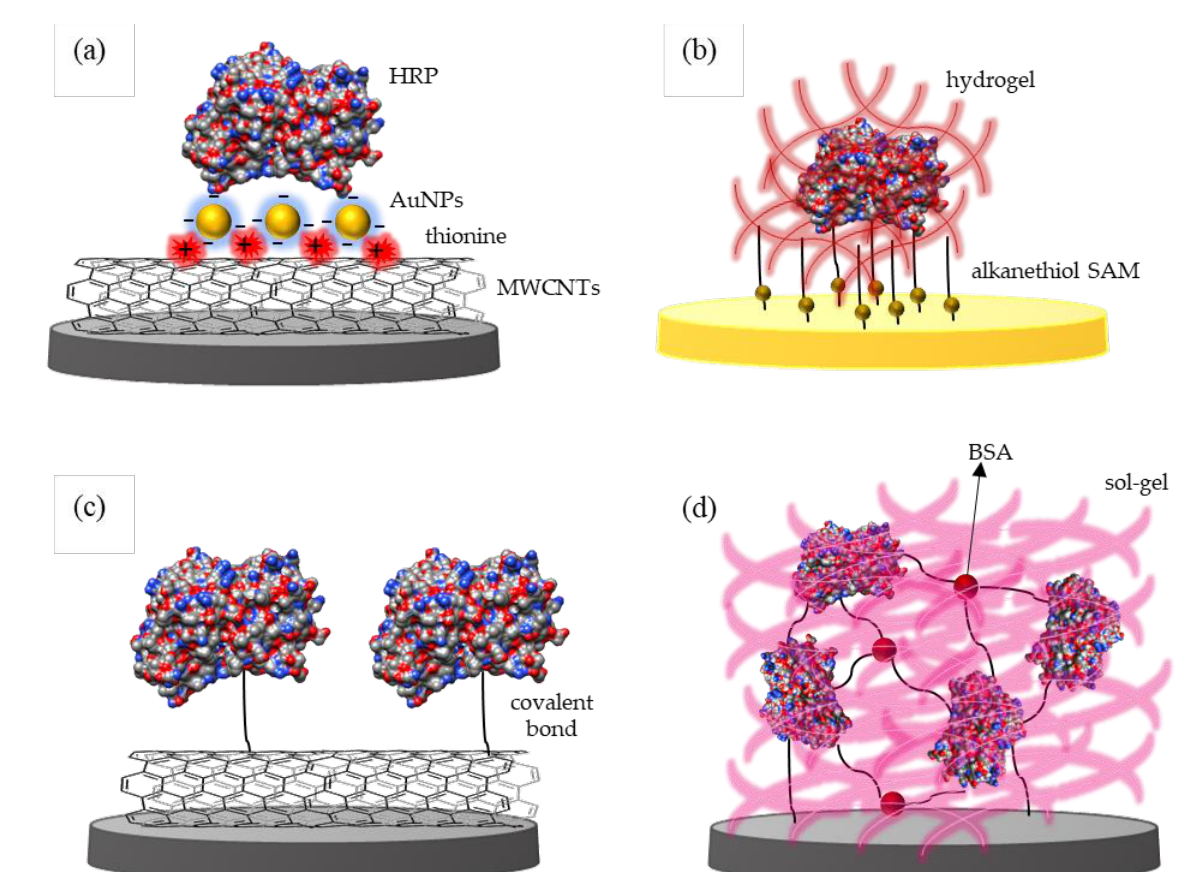
Figure 2. Enzyme immobilization methods. ( a ) A dsorption onto a multi-walled carbon nanotubes (MWCNTs)/thionine/Au nanoparticles (NPs) composite film on glassy carbon (GC) [37]; ( b ) entrapment of chemically modified enzyme within a positively charged redox hydrogel deposited on Au coated with a negatively charged self-assembled monolayer (SAM) [38]; ( c ) covalent binding onto functionalized MWCNTs deposited on GC [39]; ( d ) glutaraldehyde cross-linking of enzyme and bovine serum albumin (BSA) on a silica-dextran nanocomposite sol-gel deposited on GC [40]. HRP—horseradish peroxidase.